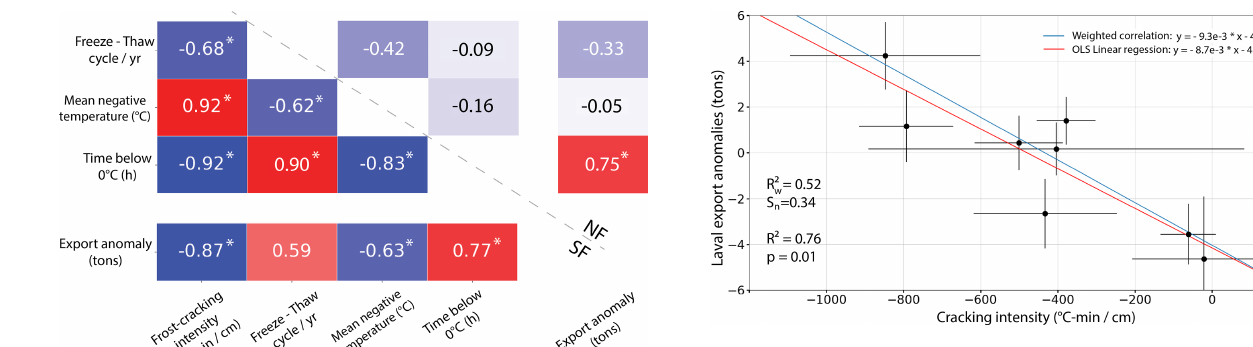
Figure 8. Regression analysis between sediment export anomalies and frost-cracking intensity on the south-facing slope for the years 2007–2010, 2014, 2015, 2017, and 2020. Horizontal error bars refer to the difference between measurements at uphill and downhill lo- cations (temperature measurements for 2017 were only available for the downhill location; thus, uncertainty on frost-cracking intensity was computed as the average of the uncertainties from the others years); vertical error bars are ± 2 σ uncertainty in export anomaly. The red line shows ordinary least-squares (OLS) linear regression; the blue line shows weighted linear regression following York et al. (2004). Weighted determination coefficients R 2 w and associated nor- malized goodness-of-fit indicator S n = S/ ( n − 2) are indicated for the weighted regression. The standard R 2 and associated p value indicate the significance of the ordinary least-squares (unweighted)